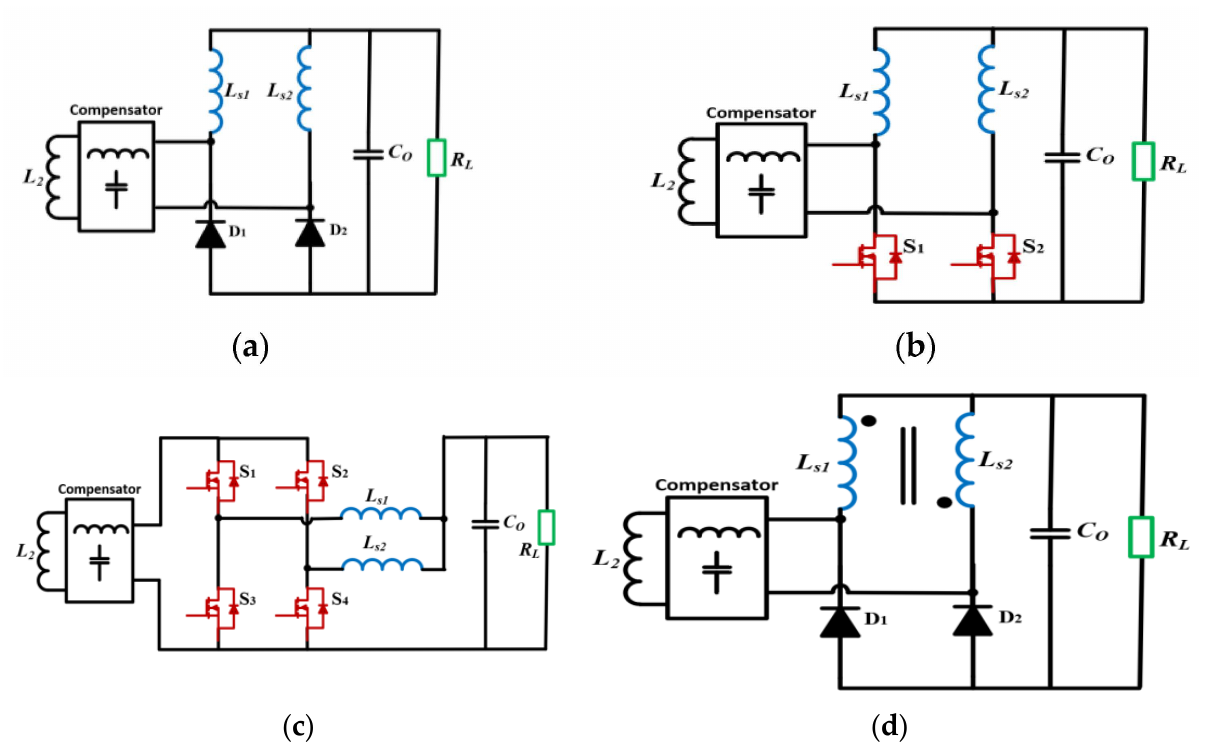
Figure 21. Secondary circuit diagrams of IPT system based on current double rectifiers CDR. ( a ) Conventional CDR [133]. ( b ) CDR with active switches [134], ( c ) current double synchronous recti- fier CDSR [135] and ( d ) inverse coupled current double rectifier ICCDR [127].